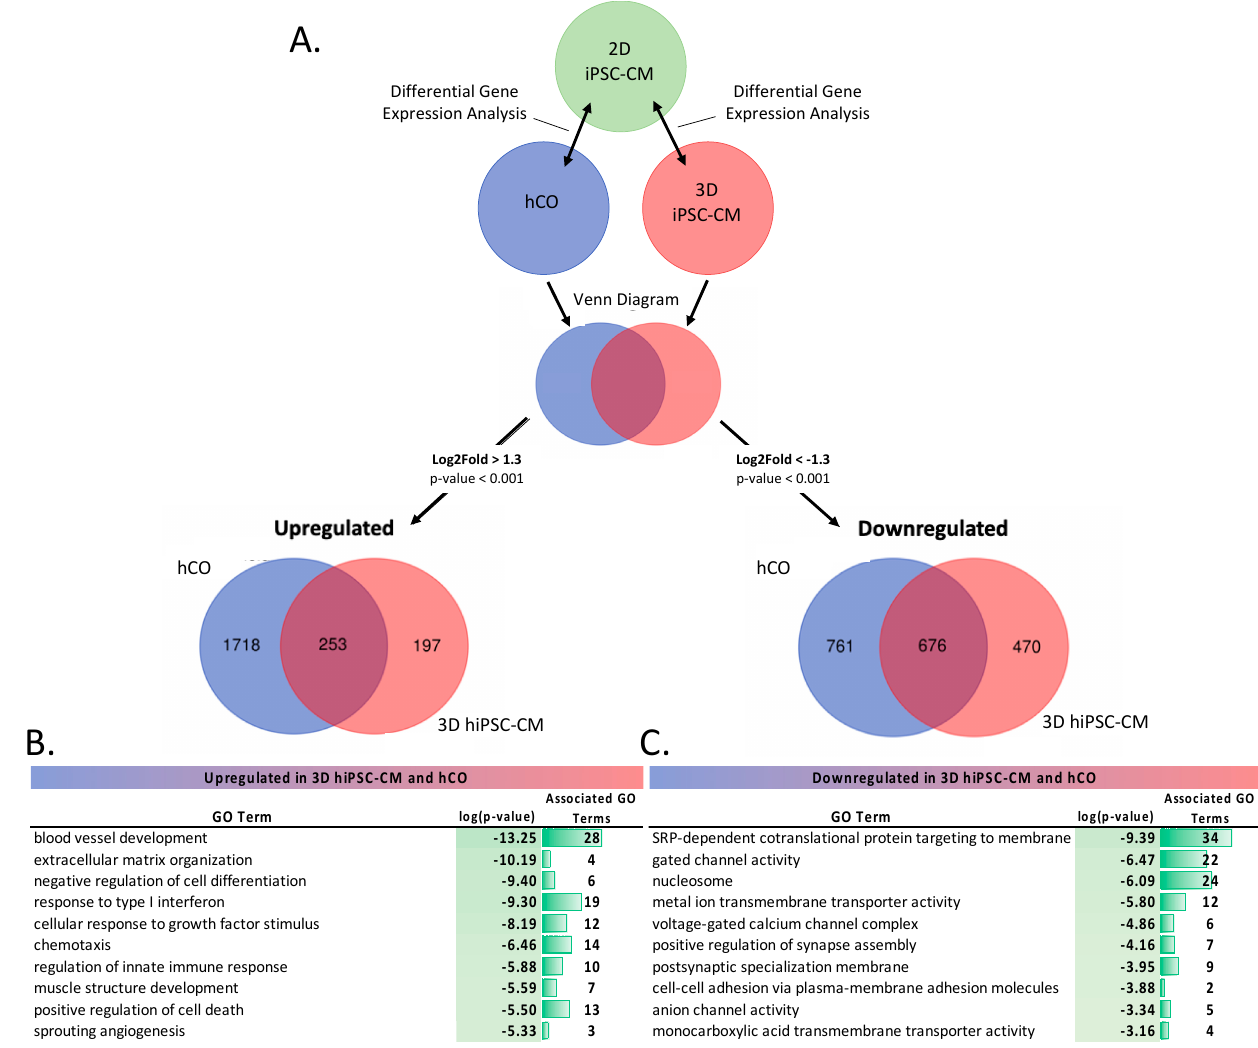
Figure 3. DGE analysis of in vitro models ( A ) Schematic representation of the DGE analysis. DESeq2 was performed on hCOs ( n = 3) and 3D hiPSC-CMs ( n = 3) samples compared to 2D hiPSC-CMs ( n = 3) samples. Results were filtered for DEGs with a |log2fold change| > 1.3 and p -value < 0.001. Differentially expressed genes were split into upregulated (log2fold change > 1.3) and downregulated (log2foldchange < − 1.3). A Venn diagram of upregulated and downregulated genes was performed. ( B , C ) Pathway analysis of upregulated ( B ) and downregulated ( C ) differentially expressed genes expressed in both hCOs and 3D hiPSC-CMs.